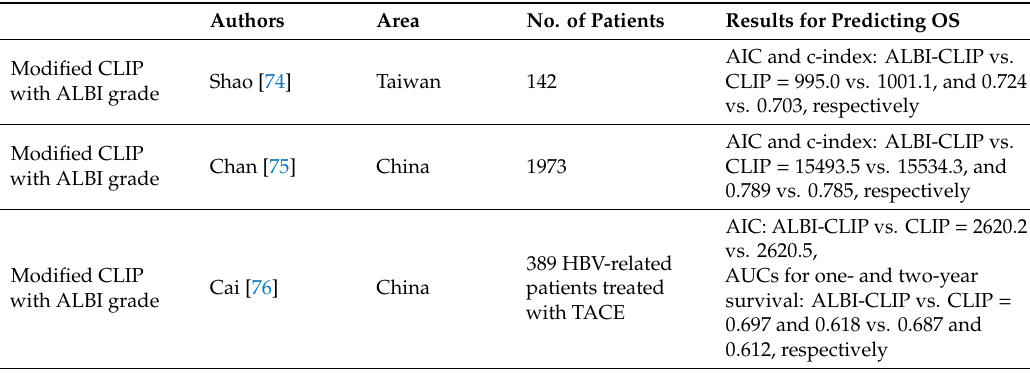
Table 3. Total scoring staging systems using ALBI and mALBI